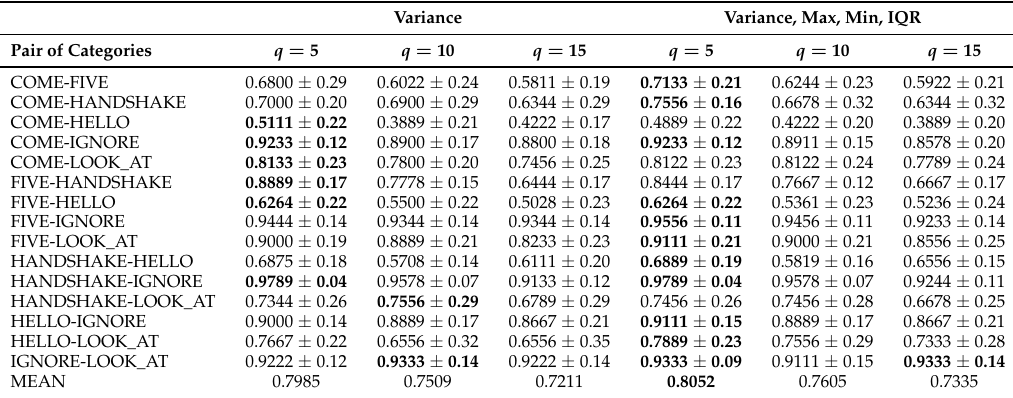
Table 3. Results obtained applying CSP with different q values and using RF as classifier. Variance Variance, Max, Min,